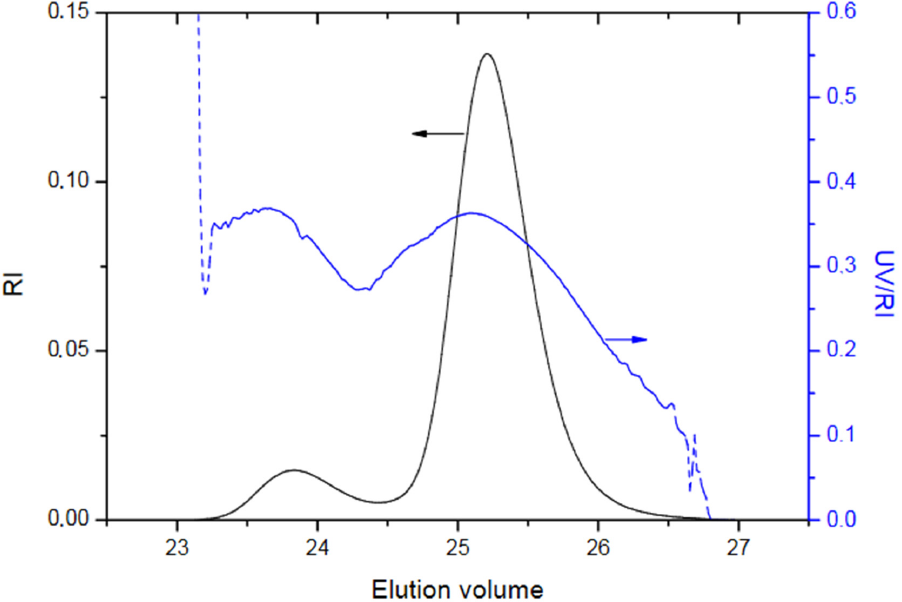
Figure 12. SEC elugram of Sample C2.